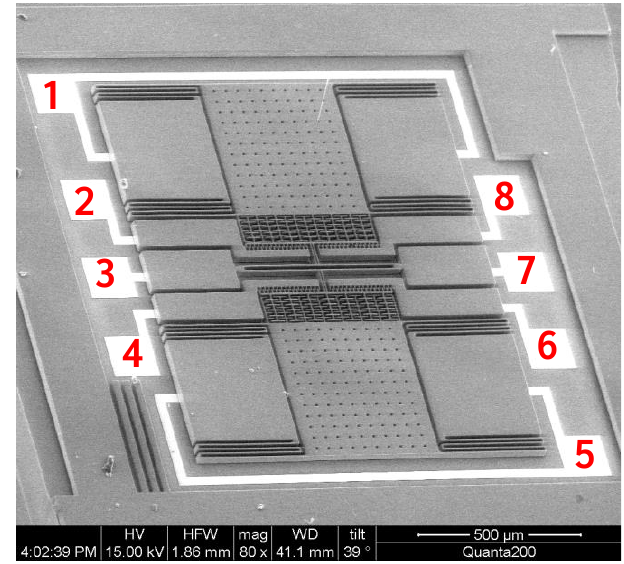
Figure 11. Fabricated microstructure (double-stage beam).